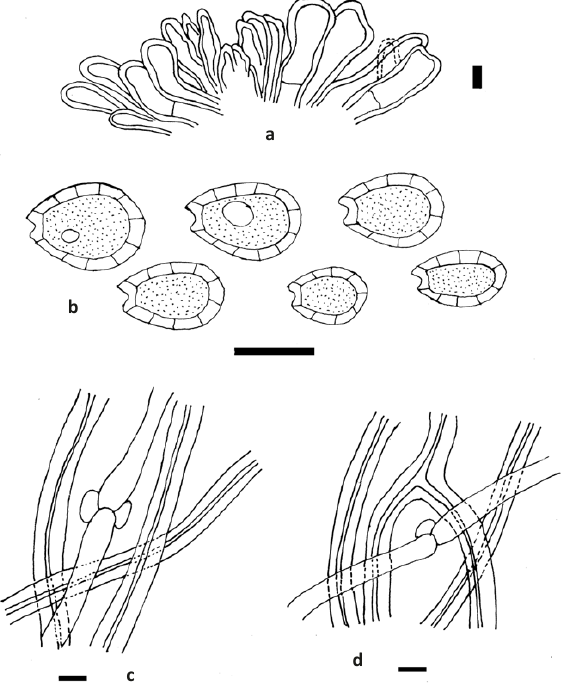
Figure 5. Ganoderma lucidum var. lucidum . a - hyphae of the cutis, b - basidiospores, c - context hyphae, d - tube layer hyphae. Bars = 5µm. Drawing by R. Saha.